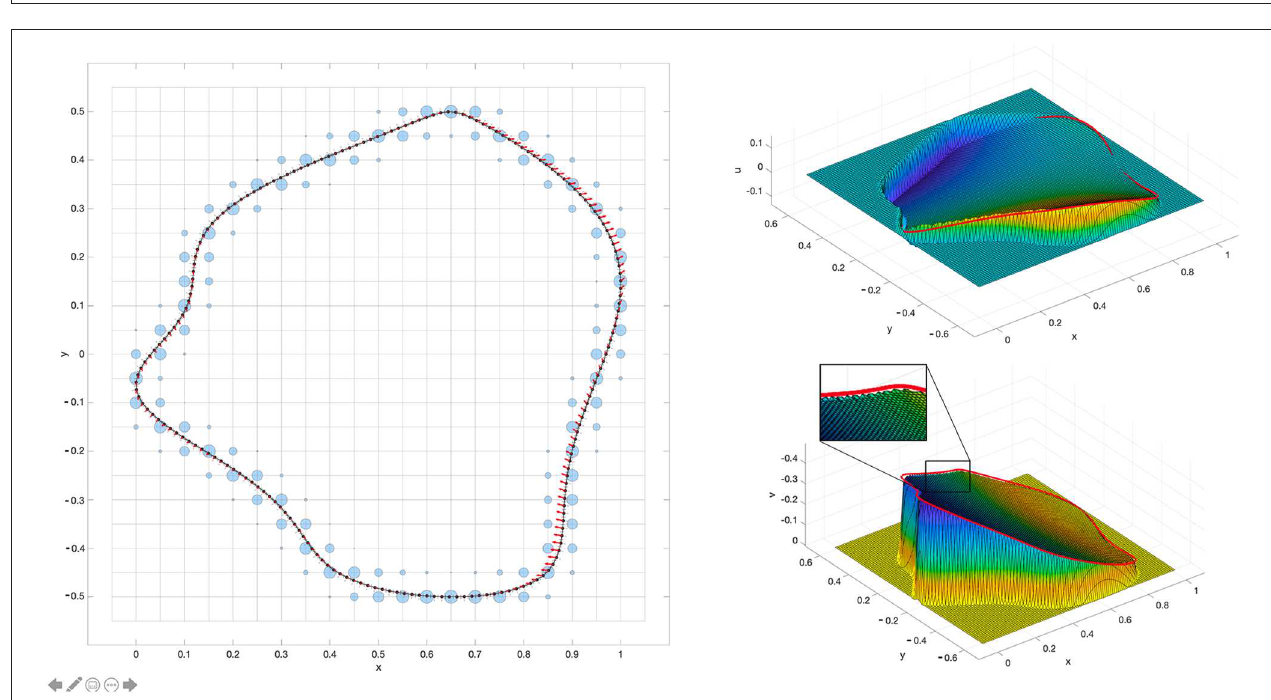
FIGURE 3 | Raw results for the displacements of an arbitrary shape. The results are displayed as in Figure 2 , here however the shape is cut out of a rectangular beam (see right graph in Figure 1 ) with an end load F = 0.2 and dimensions a = 1 and b = 0.5. For the elastic parameters it was chosen ν = 0.3 and µ = 1.